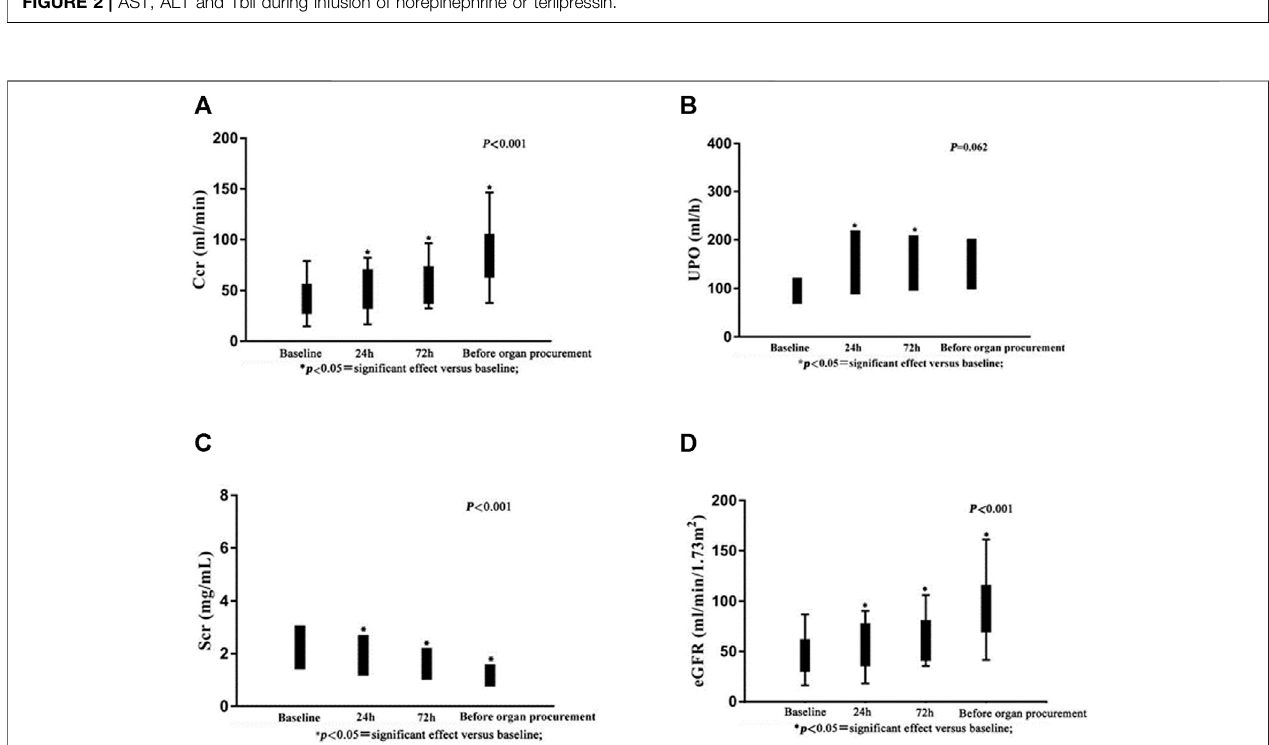
FIGURE 3 | Serum creatinine, urine output, creatinine clearance rate and estimated glomerular fi ltration rate after intravenous bolus dose of terlipressin.